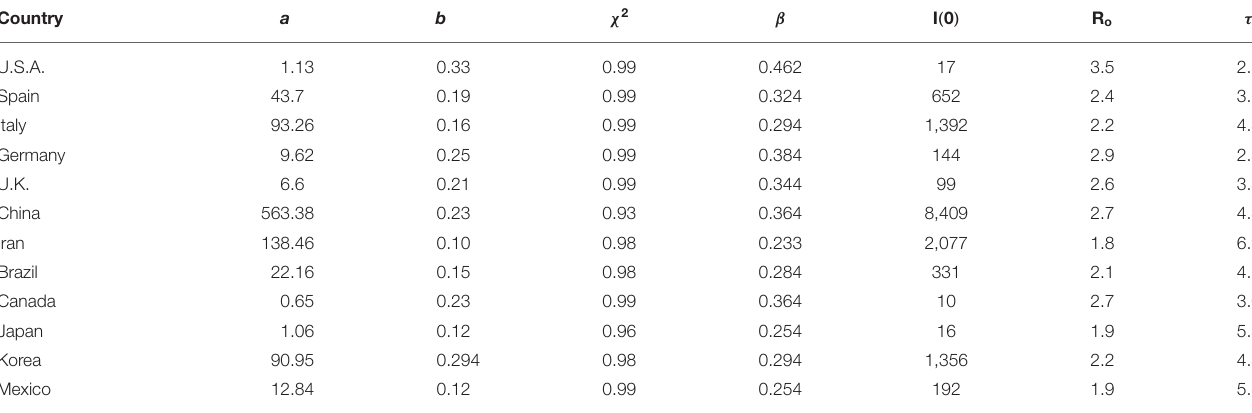
TABLE 2 | Parameters of the SIQR K model. Country a b χ 2